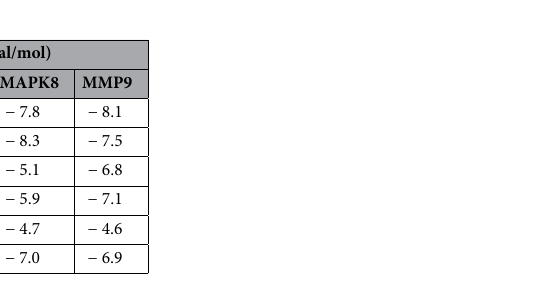
Figure 5. The compound target network associated with AA in rheumatism was produced by Cytoscape (Version, 3.8) (http:// cytos cape. org/). The rectangle, triangle, and circle represent the component, target, and rheumatism-related pathway.